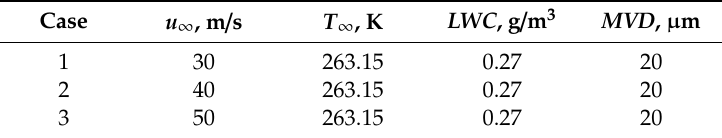
Figure 7. Computational domain size and boundary conditions. Table 3. Experimental conditions.